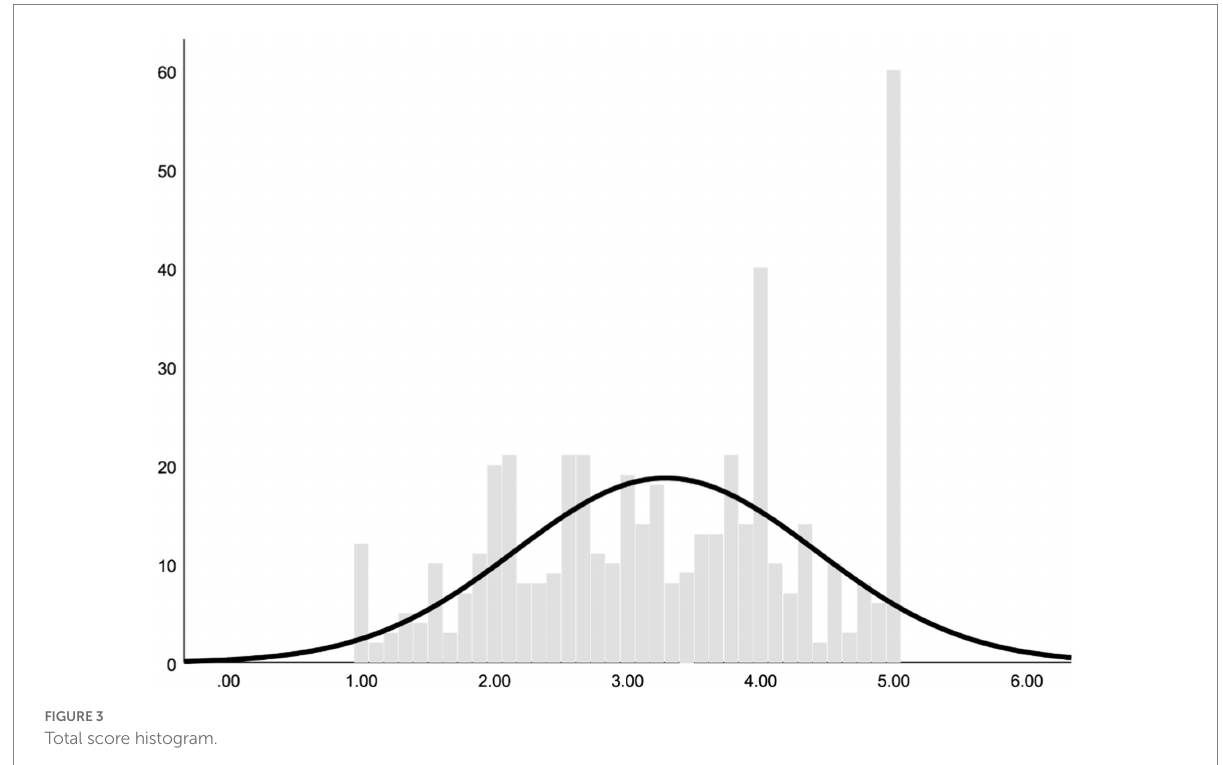
FIGURE 3 Total score histogram.